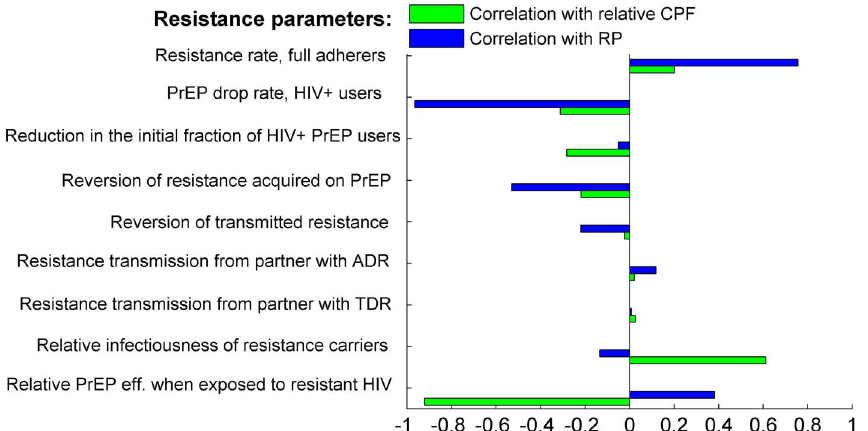
Figure 4. Partial rank correlation coefficients (PRCC) between resistance-related parameters and intervention outcomes, relative 10-year CPF (green) and resistance prevalence after 10 years (blue) based on 10, 000 simulations (10 per preselected epidemic set). The intervention parameters are fixed on their baseline values from Table 1, part C. Relative CPF is calculated as the ratio of the 10-year CPF for scenarios with resistance over baseline scenario (no resistance).